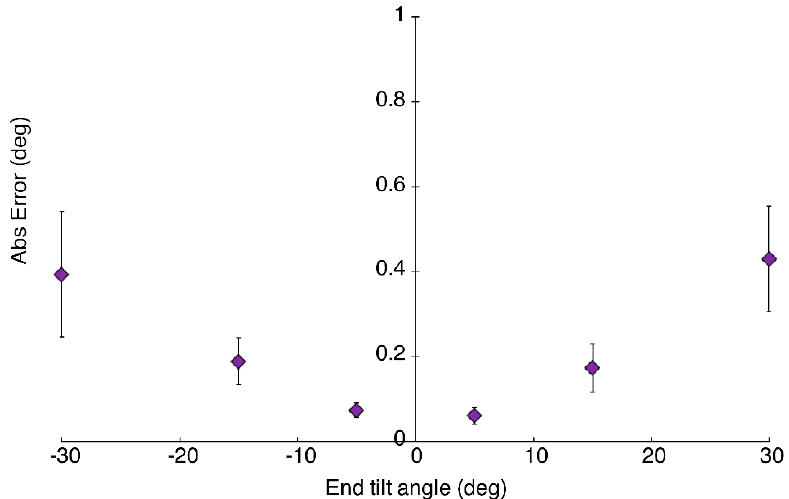
Figure A2. Mean absolute error in pitch measurements for each end-point tilt angle. Error bars represent standard error.